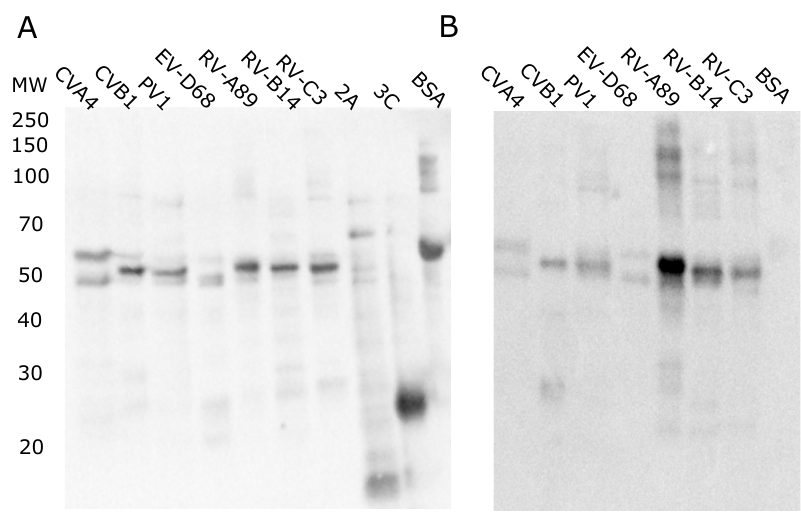
Figure 2. Antigen quality control. ( A ) The detection of biotinylation using neutral chimeric avidin and anti-avidin antibody. ( B ) Antigen detection in Western blot using pooled human serum